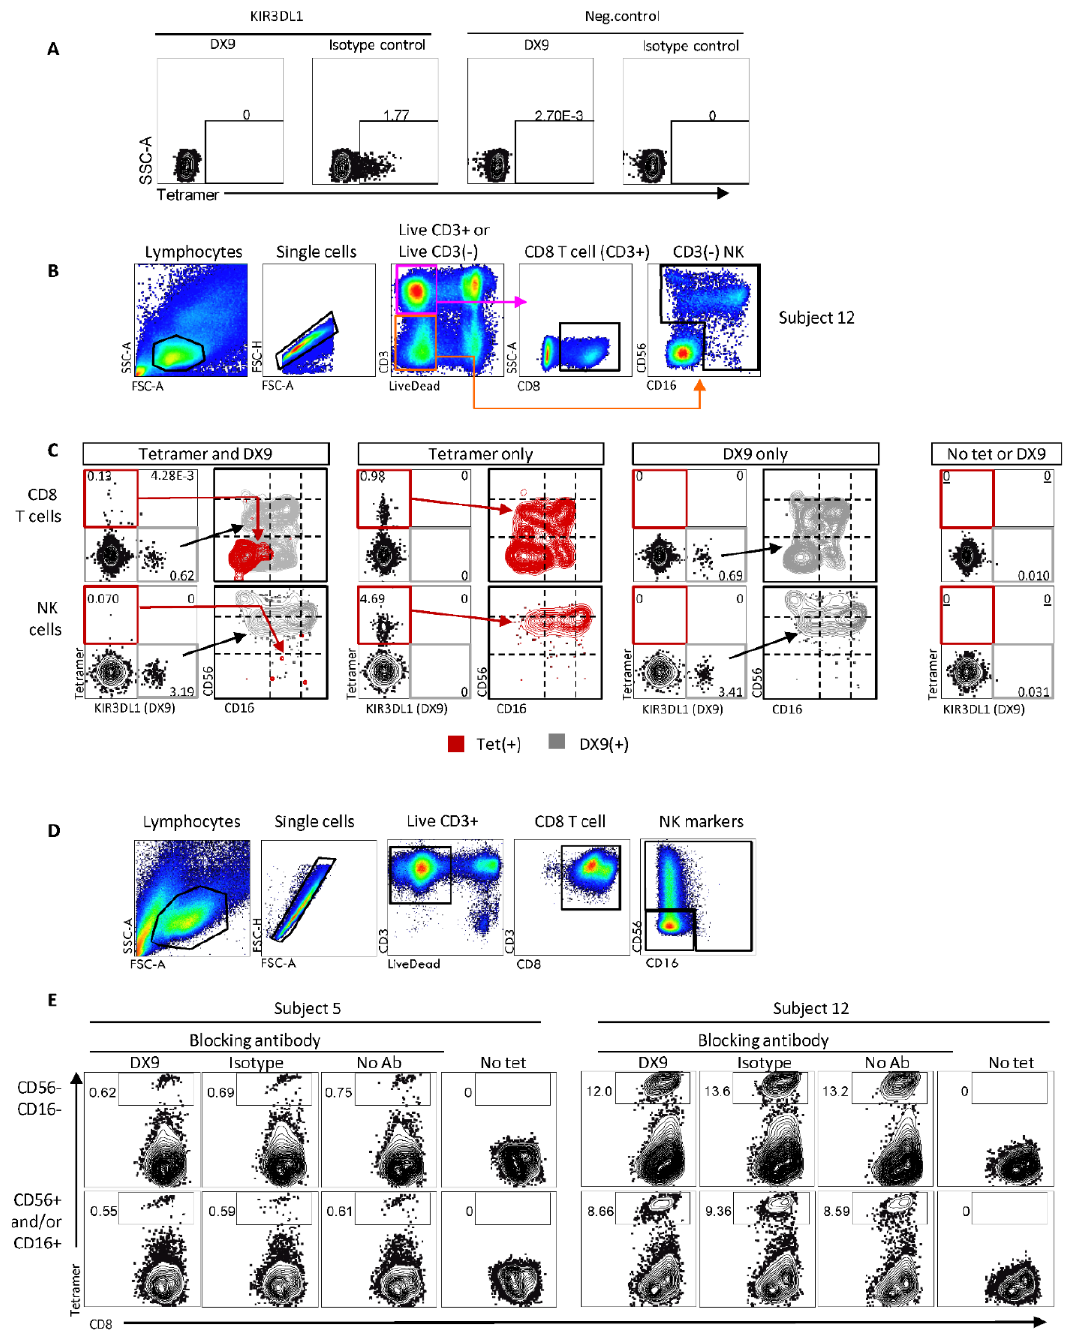
Figure 2. B57-RTR tetramer binds NK and T cells in a KIR3DL1-dependent and -independent manner. ( A ) B57-RTR tetramer binds COS-7 cells transfected with KIR3DL1, but not to cells transfected with